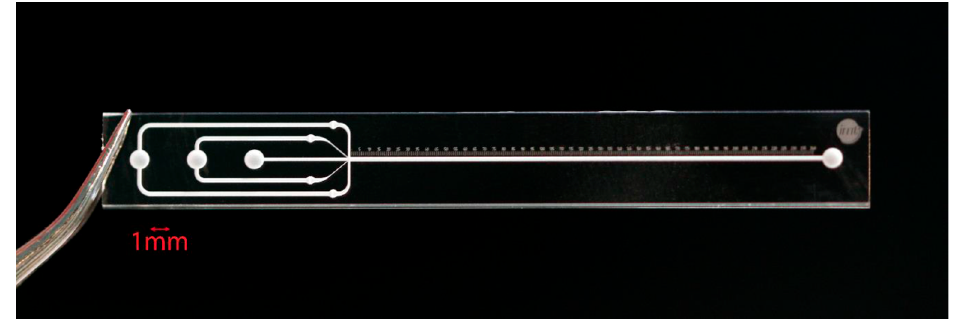
Figure A1. Photograph of the mixer chip